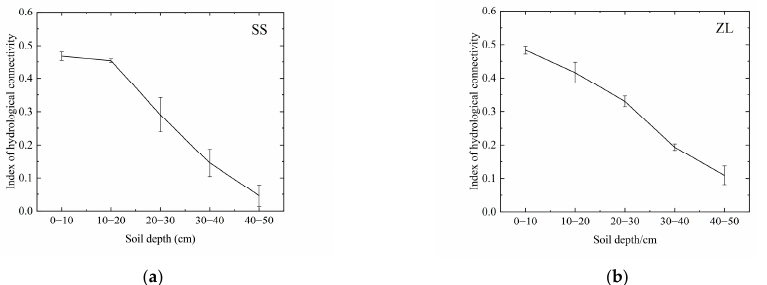
Figure 4. Change trend of IHC with increasing soil depth in the two sites: ( a ) Change trend of the IHC values in the SS site with increasing soil depth; ( b ) Change trend of the IHC values in the ZL site with increasing soil depth.